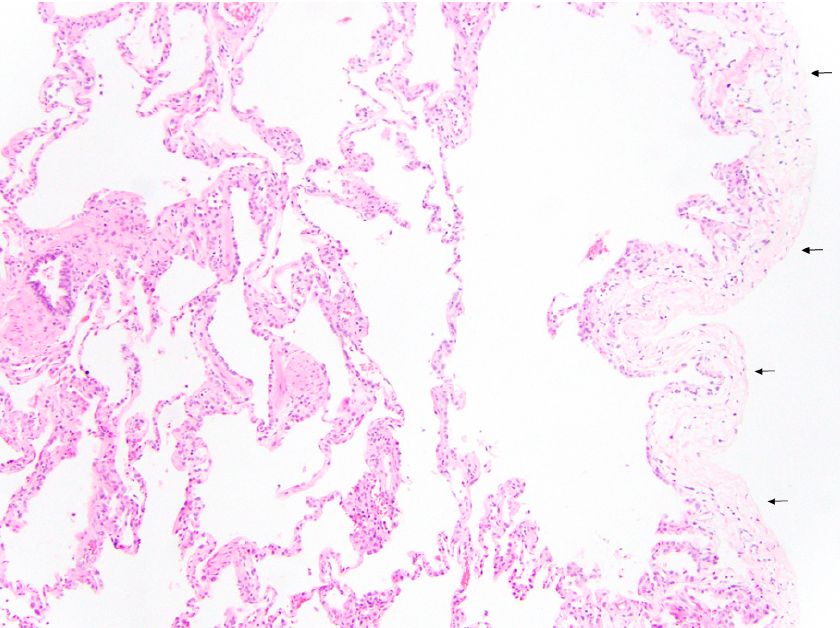
Figure 4. Histology in prematurity-related lung disease. Wedge biopsy sample from a 2-year-old girl born at 32 and 5/7 weeks’ gestational age shows small airway remodeling, smooth muscle proliferation, and enlarged airspaces. The pleura (arrows) were thin and delicate without pathological evidence for thickening. (Hematoxylin and eosin; original magnification, 100 × ). The presence of septal thickening was statistically significantly more frequently ob- served in Group 1 (with PVS) (80% vs. 0%, p ≤ 0.001), whereas the presence of TOL was statistically significantly more frequently found in Group 2 (0% vs. 80%, p <